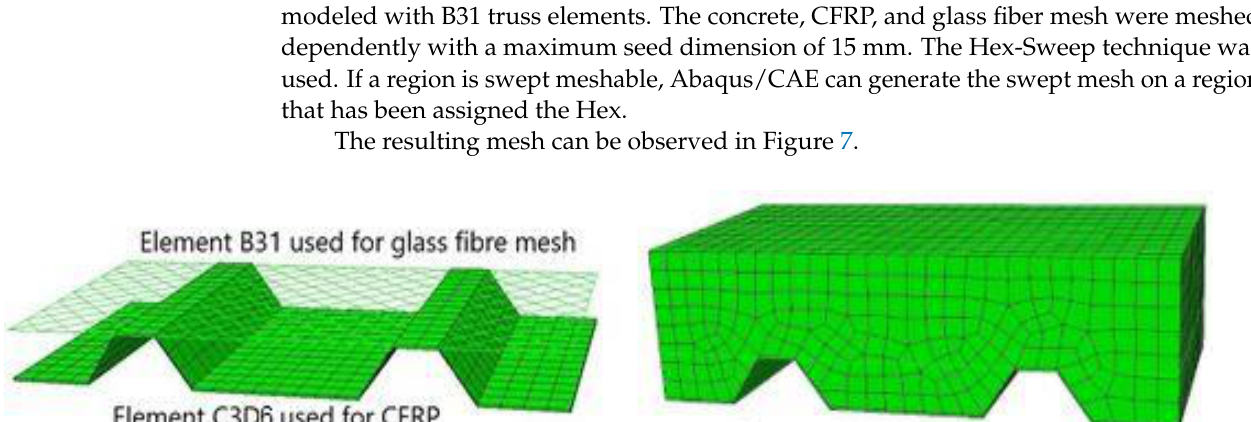
Figure 7. Mesh of the CFRP sheet and glass fiber fabric ( left ) and mesh for the concrete block ( right ), Case A-IM.